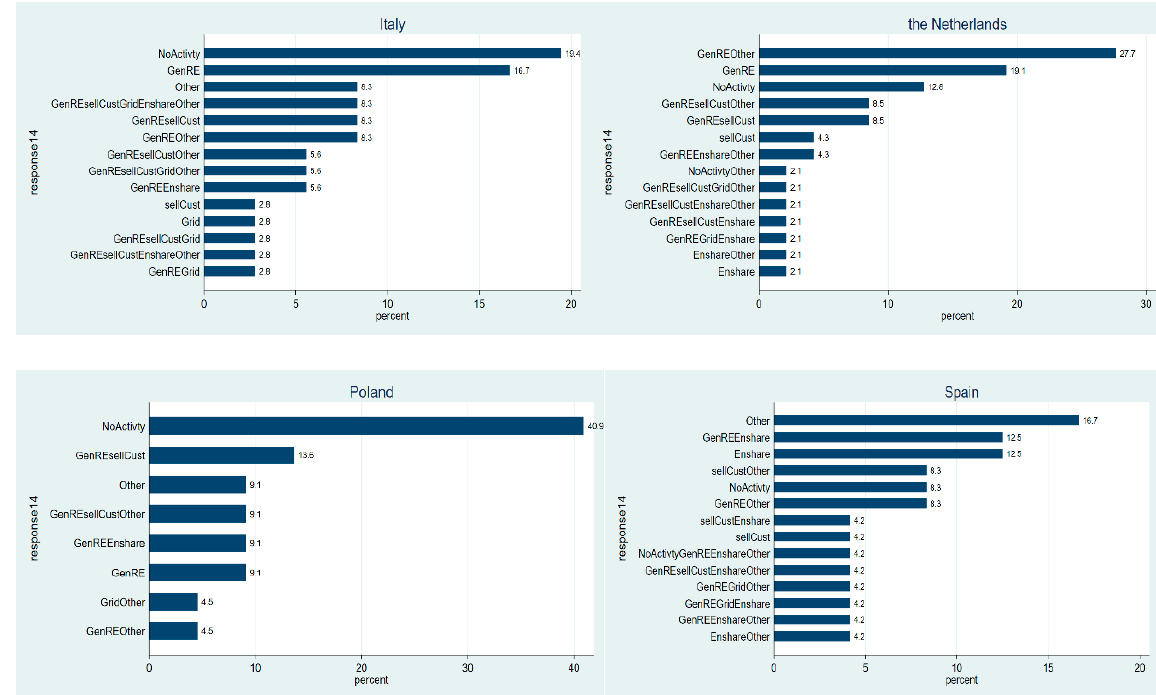
Figure A1. Energy Supply Chain Combinations. Results in percentages.